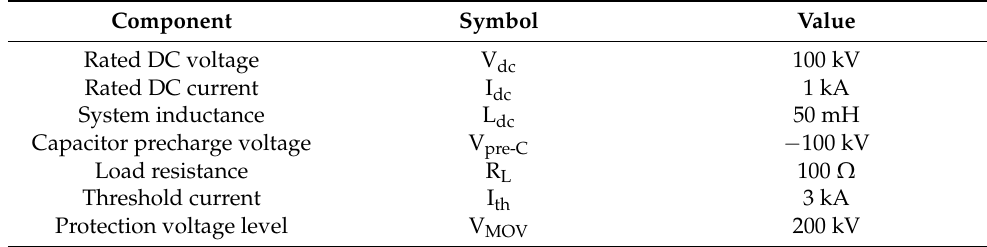
Figure 4. Configuration of the test system for optimizing parameters in the HCB. Table 3. Parameters of the HCB.